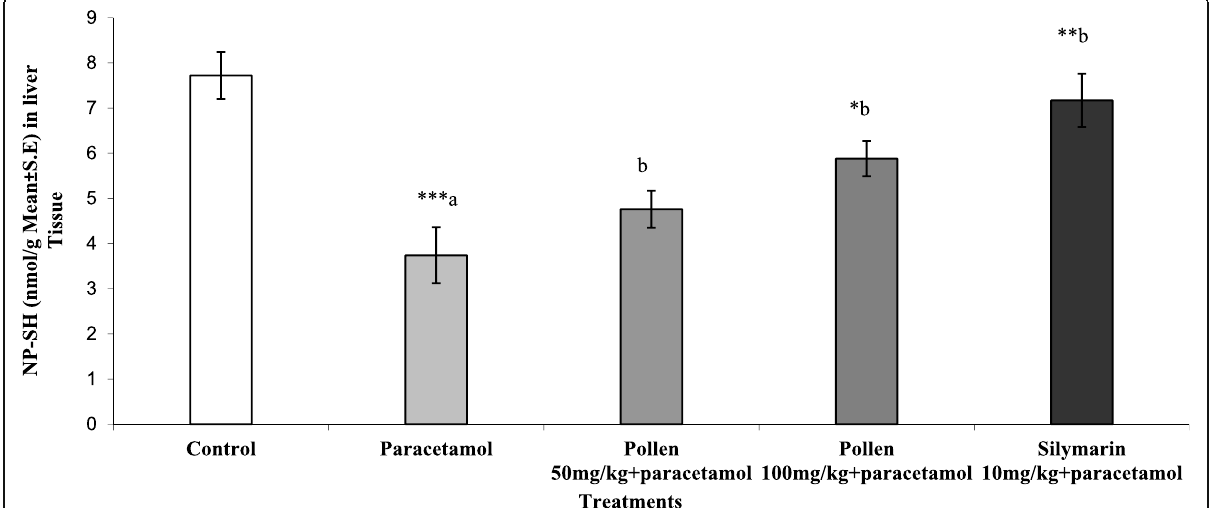
Fig. 2 Liver tissue Non Protein sulfhydryls (NP-SH) levels. NP-SH levels in rats intoxicated with APAP alone and treatment with DPP and Silymarin. All values represent mean ± SEM. * p < 0.05; ** p < 0.01, *** p < 0.001; ANOVA, followed by Dunnett ’ s multiple comparison test. a As compared with control group. b As compared with APAP group